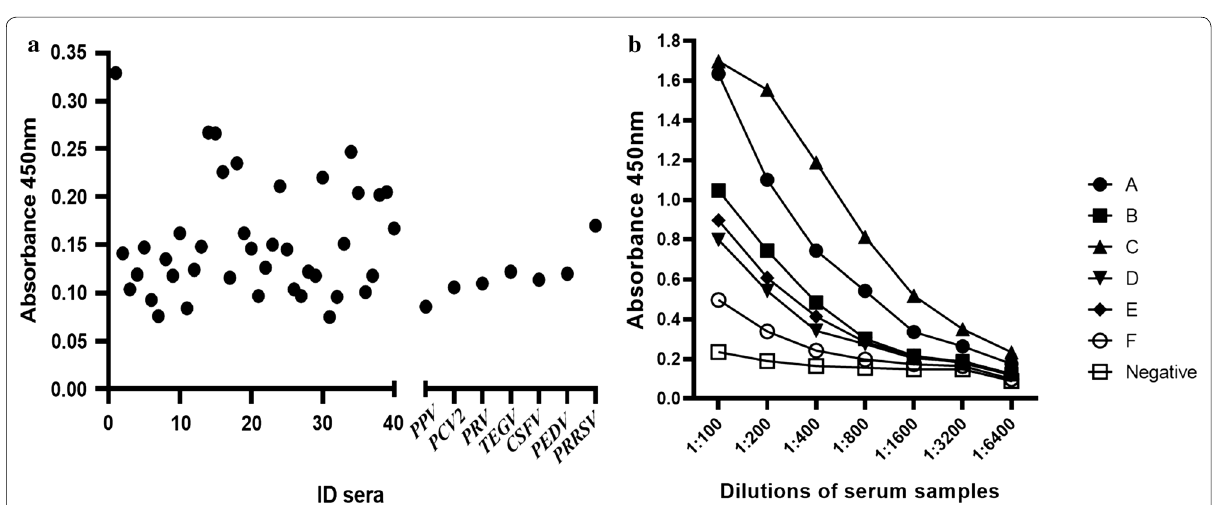
Fig. 5 a Determination of the cutoff value and specificity for VLP ELISA. b Determination of the sensitivity of VLP